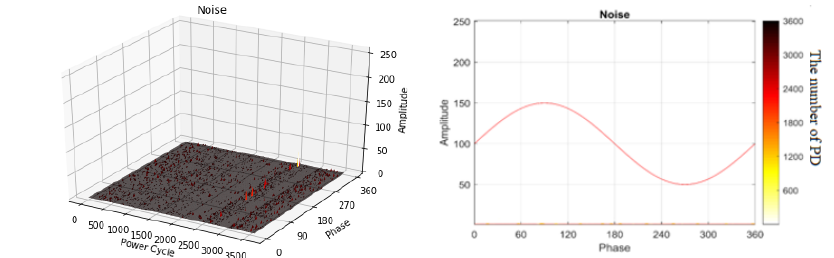
Figure 6. Example of on-site noise measurements in three-dimensional (3D) and two-dimensional (2D) representations.